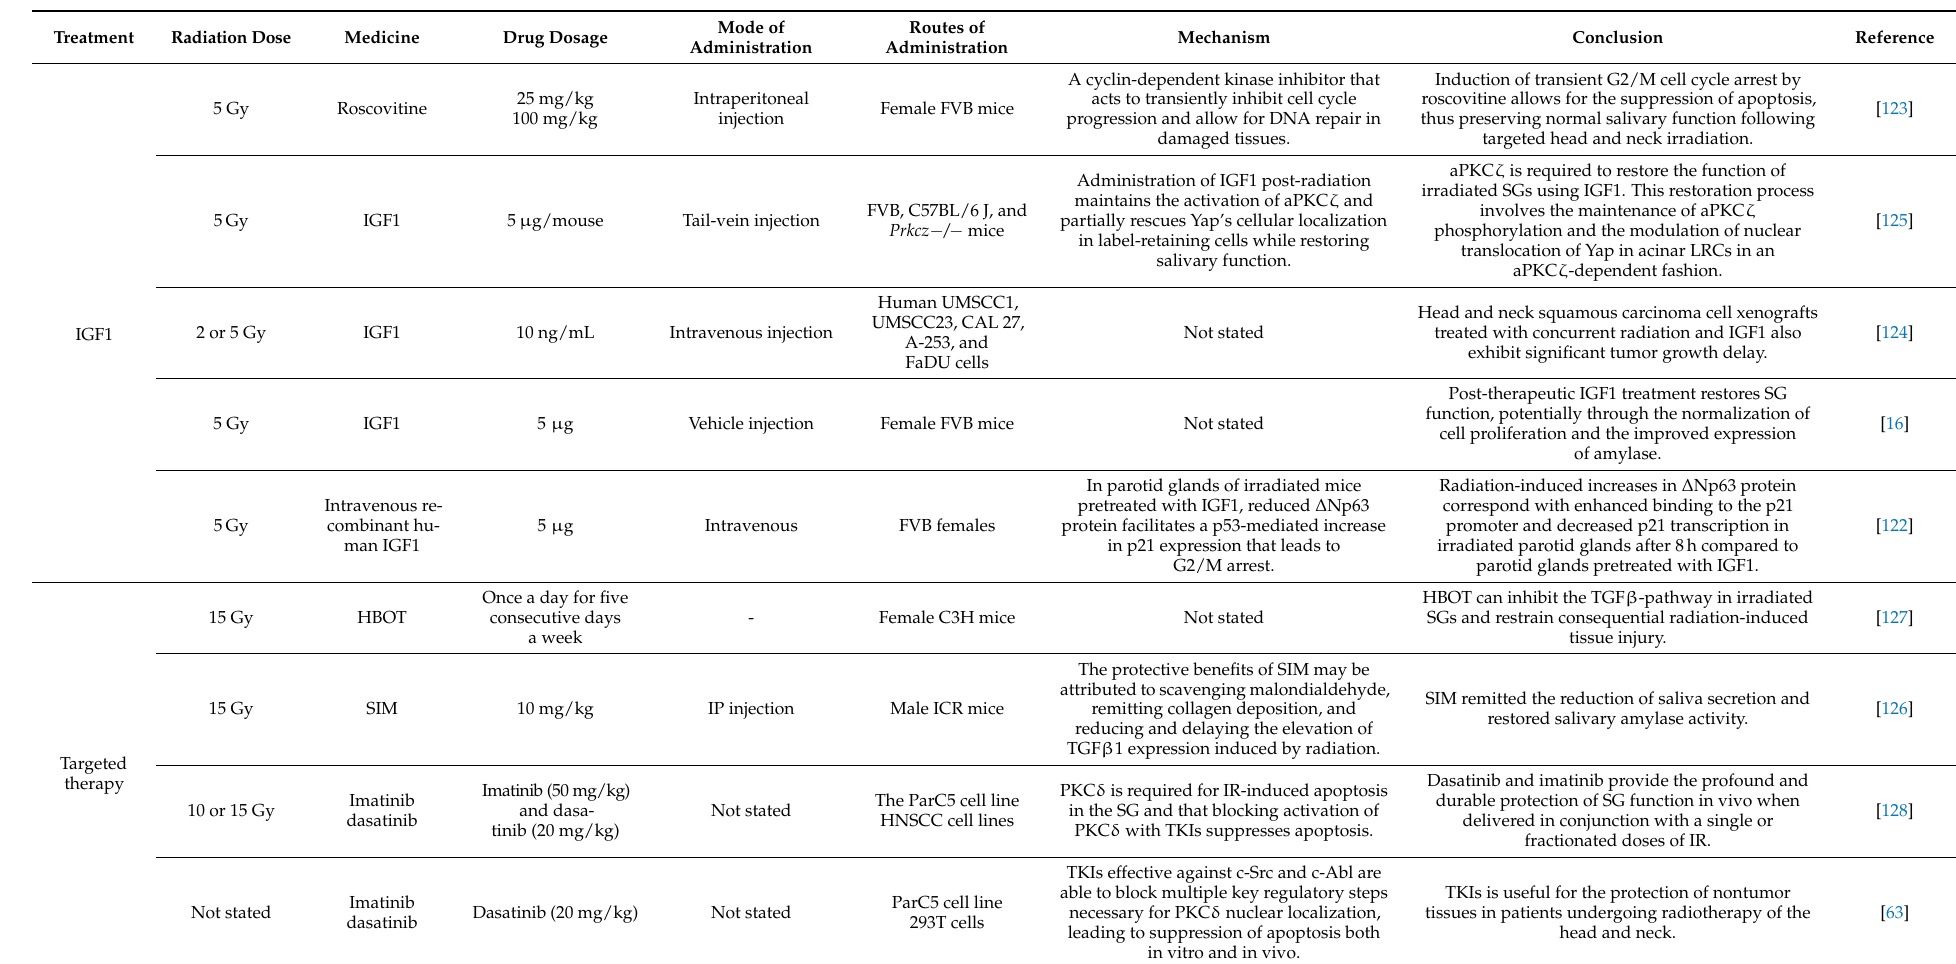
Table 1. Drug treatment of radiation-induced SG